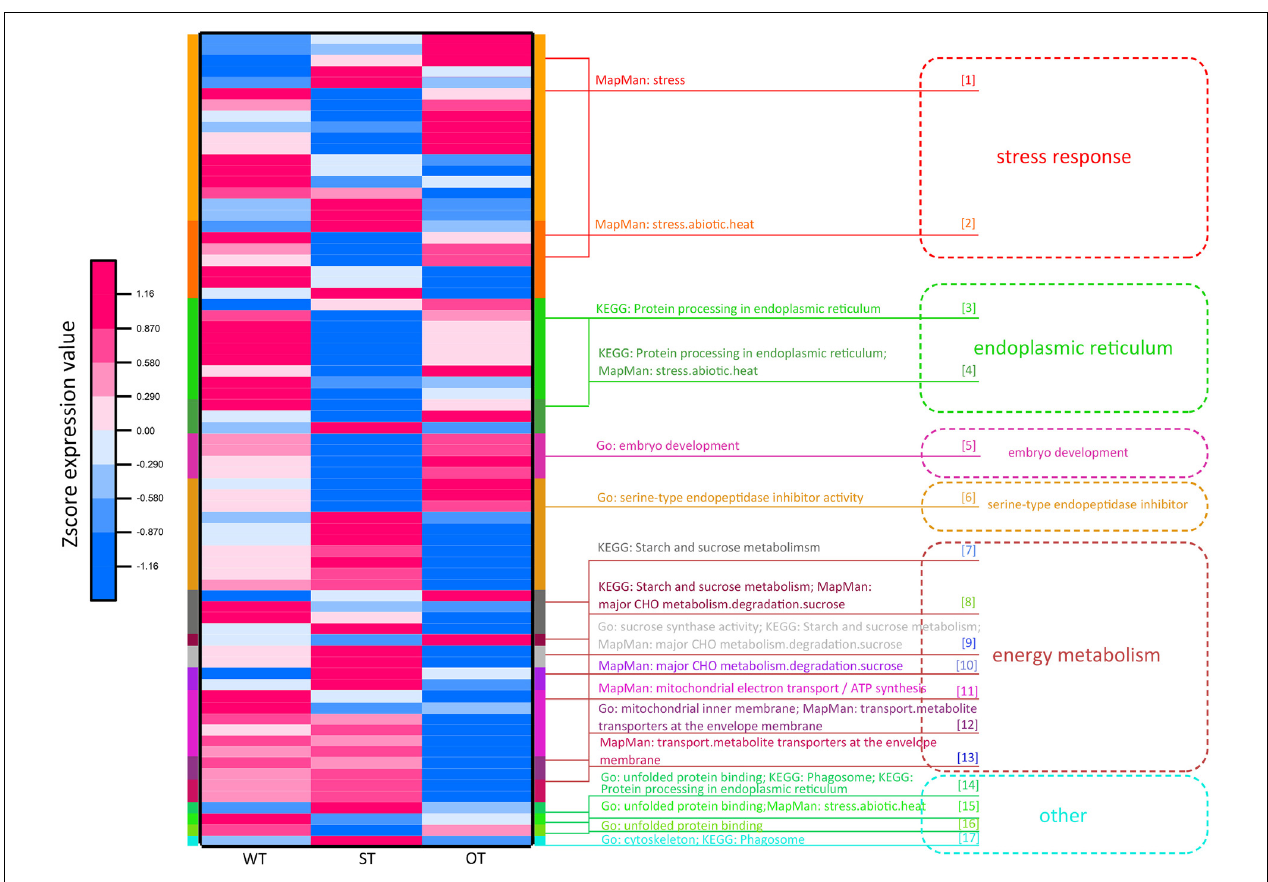
FIGURE 8 | Functional cluster heat map showing the expression levels of DEPs in WT, ST, and OT